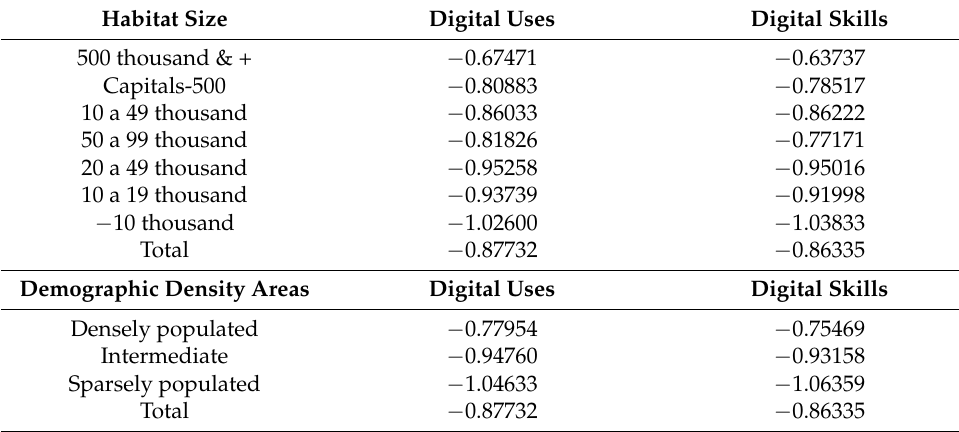
Table 7. Factor score’s means by geographic